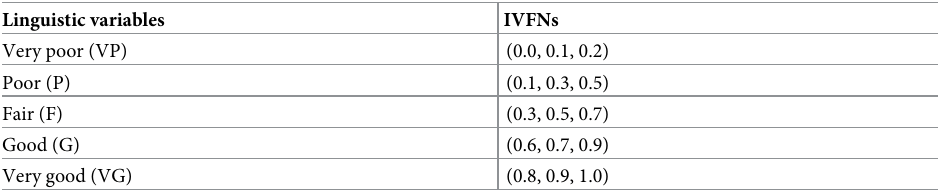
Table 2. The TFNs of linguistic variables for rating of